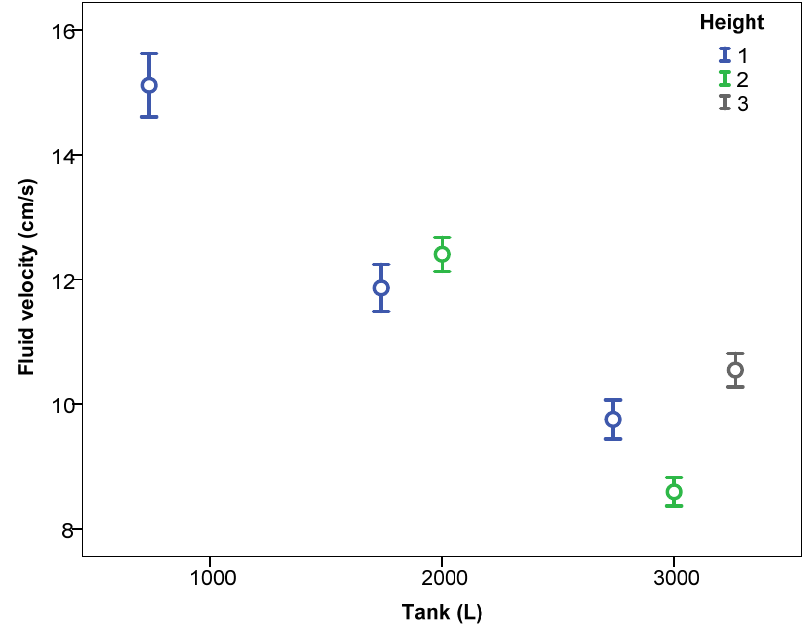
Figure 7. Fluid velocity (mean ± 95% confidence interval) according to the level of water in the tank and the height of the measurement point.